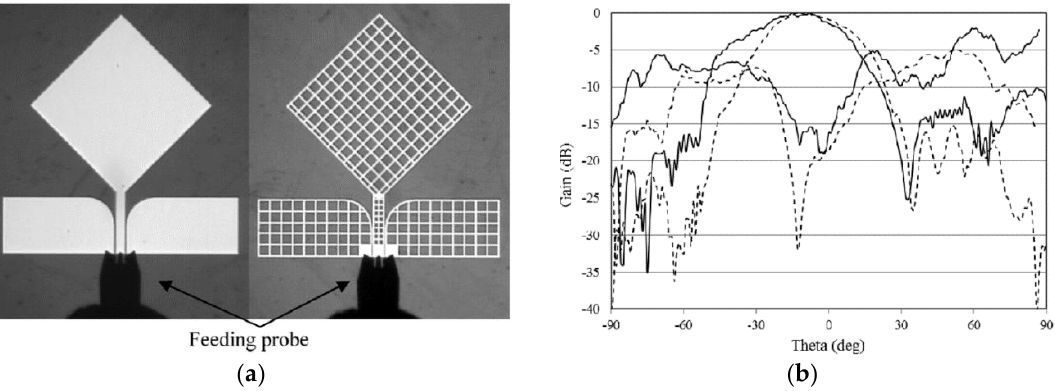
Figure 10. Photographs of the coplanar-fed monopole lozenge antennas printed on fused silica 7980 Corning substrates under measurement. ( a ) Light reflecting reference antenna and meshed transparent antenna. ( b ) Measured radiation patterns (co-polarization and cross-polarization) of the two monopole antennas at 54 GHz. Solid line: reference antenna; dotted line: optically transparent antenna [36]. (With permission from